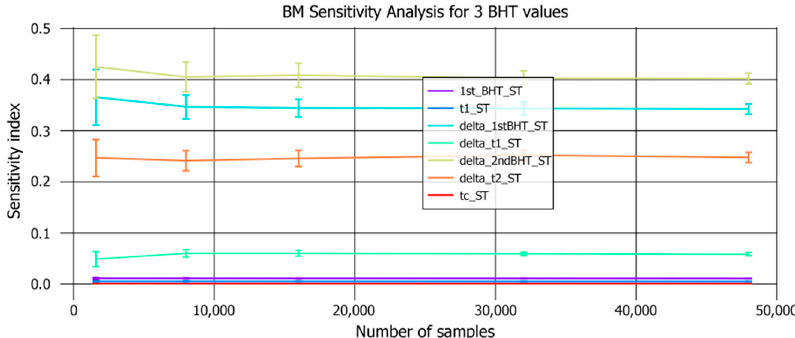
Figure 6. Proof of convergence of a Sobol model run using Brennand’s method for three BHT values.